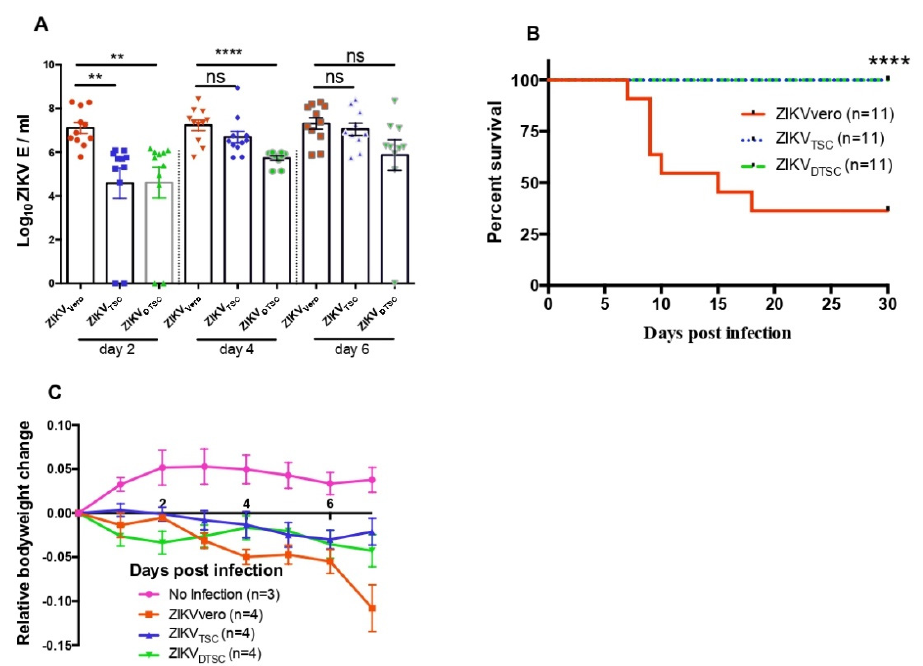
Figure 3. ZIKV TSC and ZIKV DTSC exhibit attenuated infectivity in Ifnar1 − / − mice. Four-week-old Ifnar1 − / − mice were infected with 1 × 10 4 PFU of ZIKV Vero , ZIKV TSC , or ZIKV DTSC via footpad. ( A ) The ZIKV genome copies were quantified by measuring ZIKV with qPCR and expressed as log 10 (PFU/mL). ( B ) The survival curves of Ifnar1 − / − mice infected with the different strains of ZIKV. ( C ) Relative bodyweight changes of the mice compared to the weight before infection (Day 0). The data were analyzed by a two-tailed Student t -test ( A ) or log-rank test ( B ). ** and **** denote p < 0.01, and p < 0.0001, respectively.